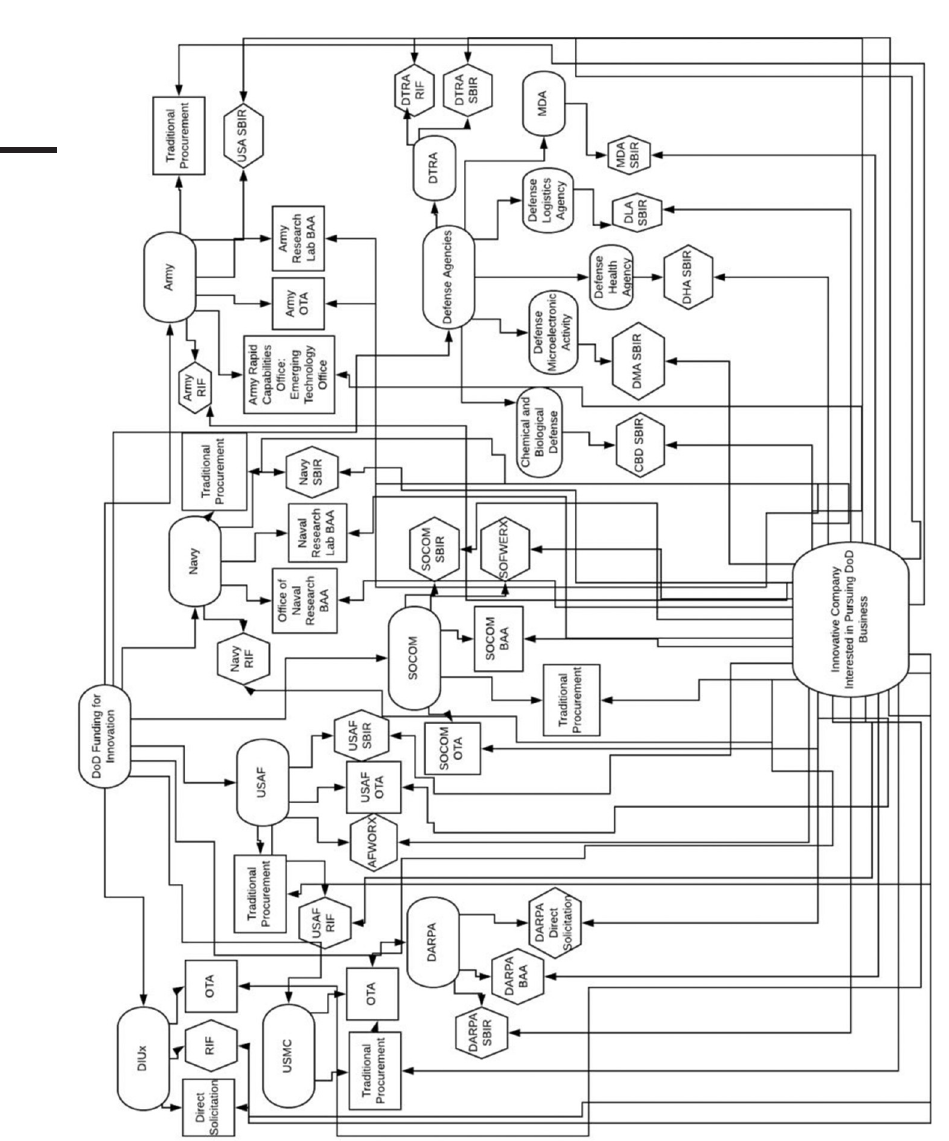
Figure 1. Access points for innovative companies into the